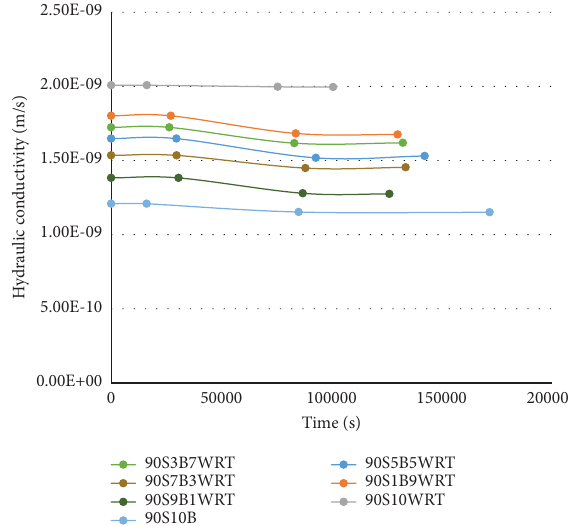
Figure 3: Hydraulic conductivity from the falling head permeability test.